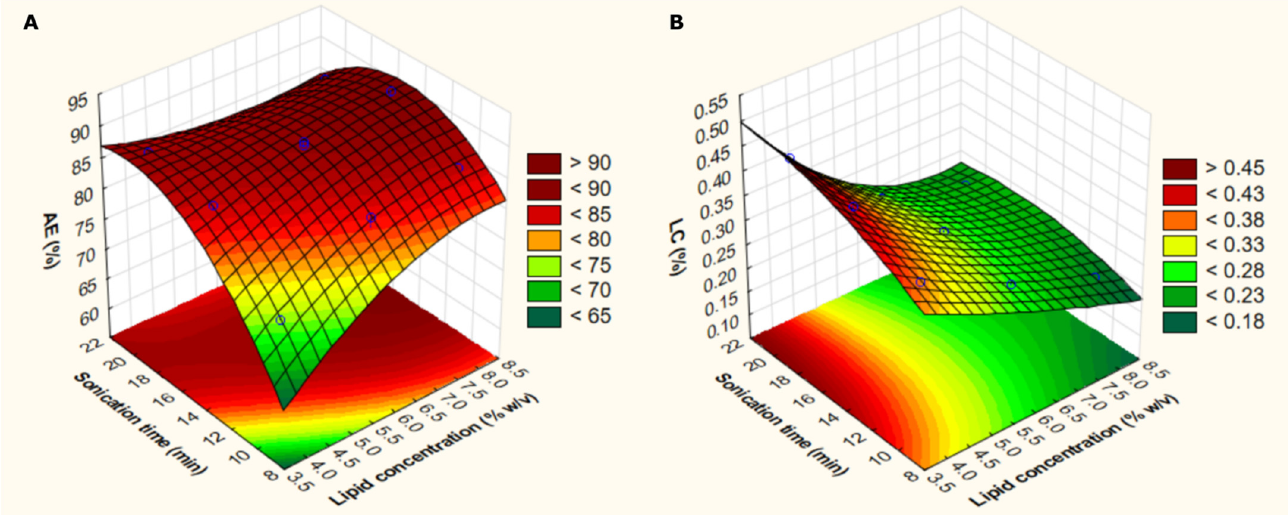
Figure 2. 3D–response surface plots considering lipid concentration and sonication time according to the analyzed response (association efficiency: AE—( A ); or loading capacity: LC—( B )). Light green indicates the lowest response level and dark red indicates the highest response level.